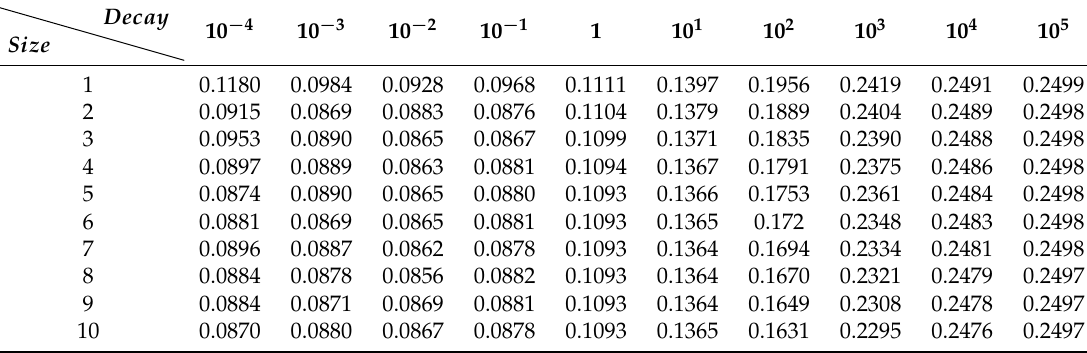
Table 10. Average Brier scores for neural network